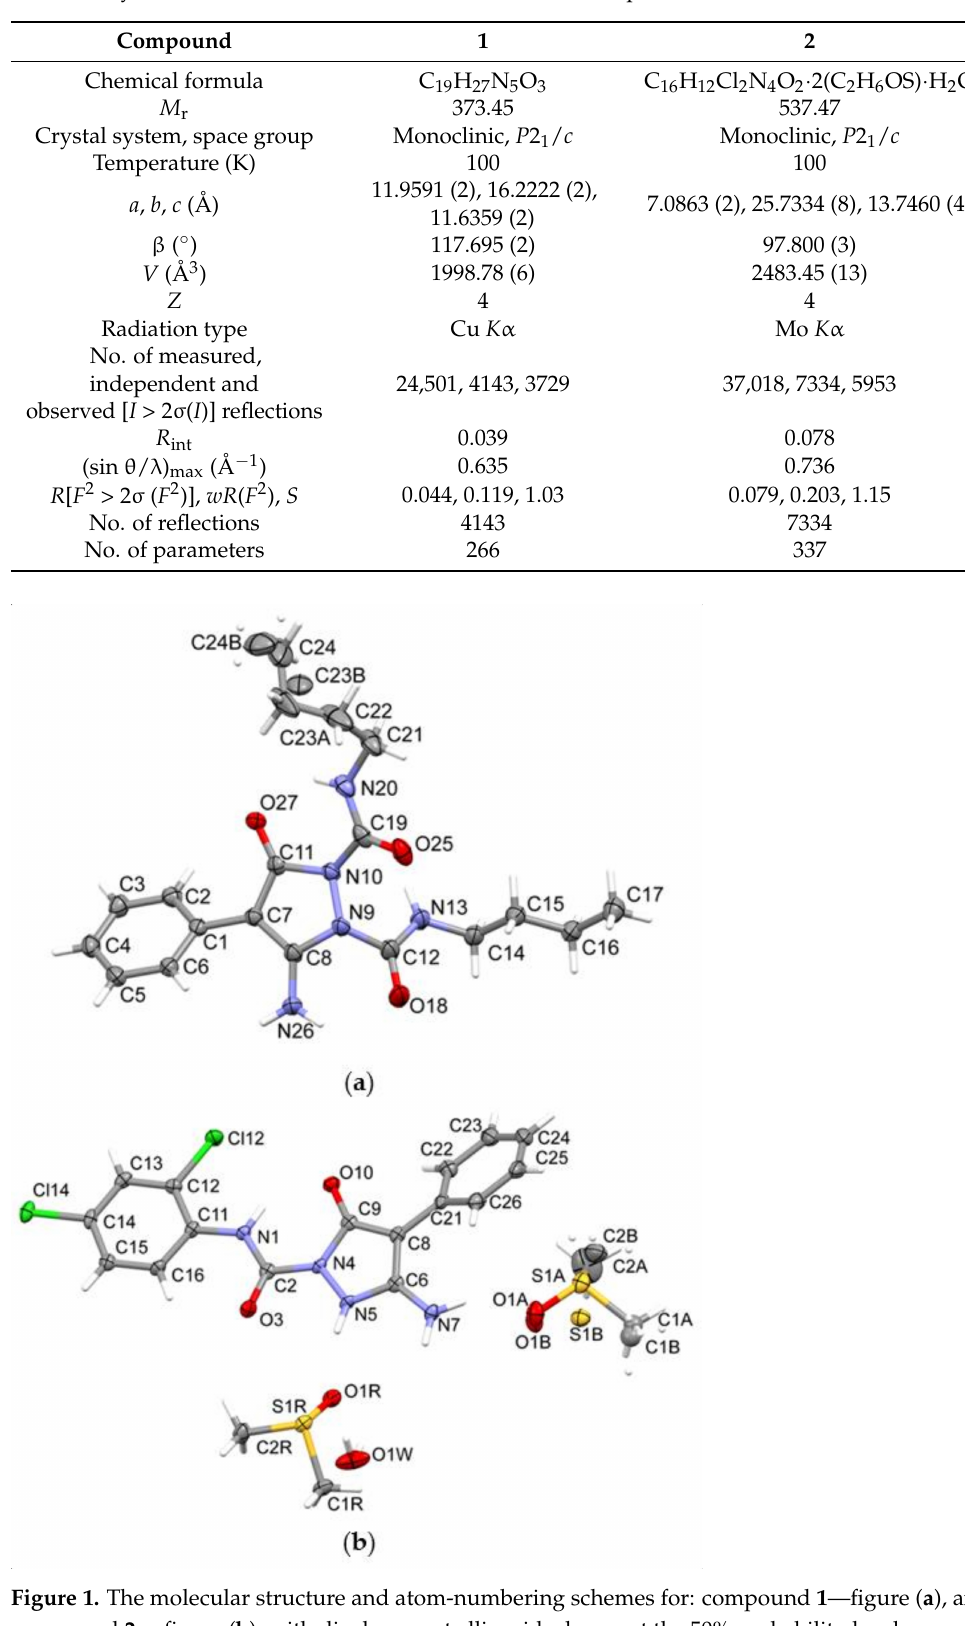
Table 1. Crystal and structure refinement data for 1 and 2 compounds.